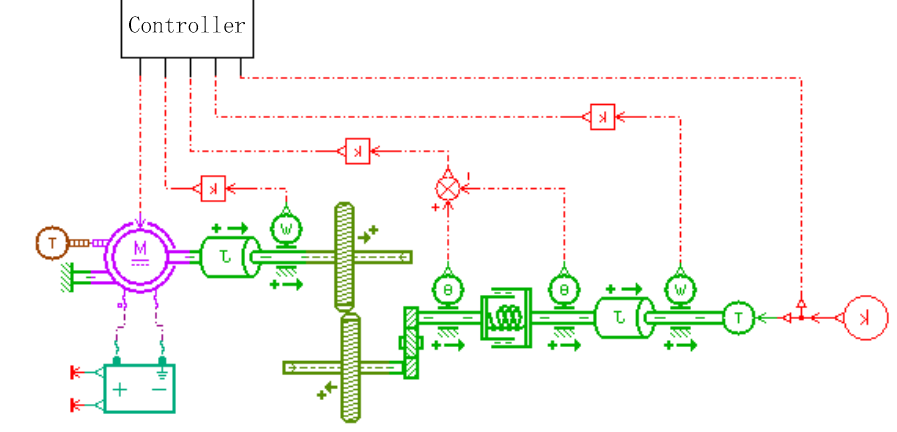
Figure 4. Electric vehicle drivetrain model.